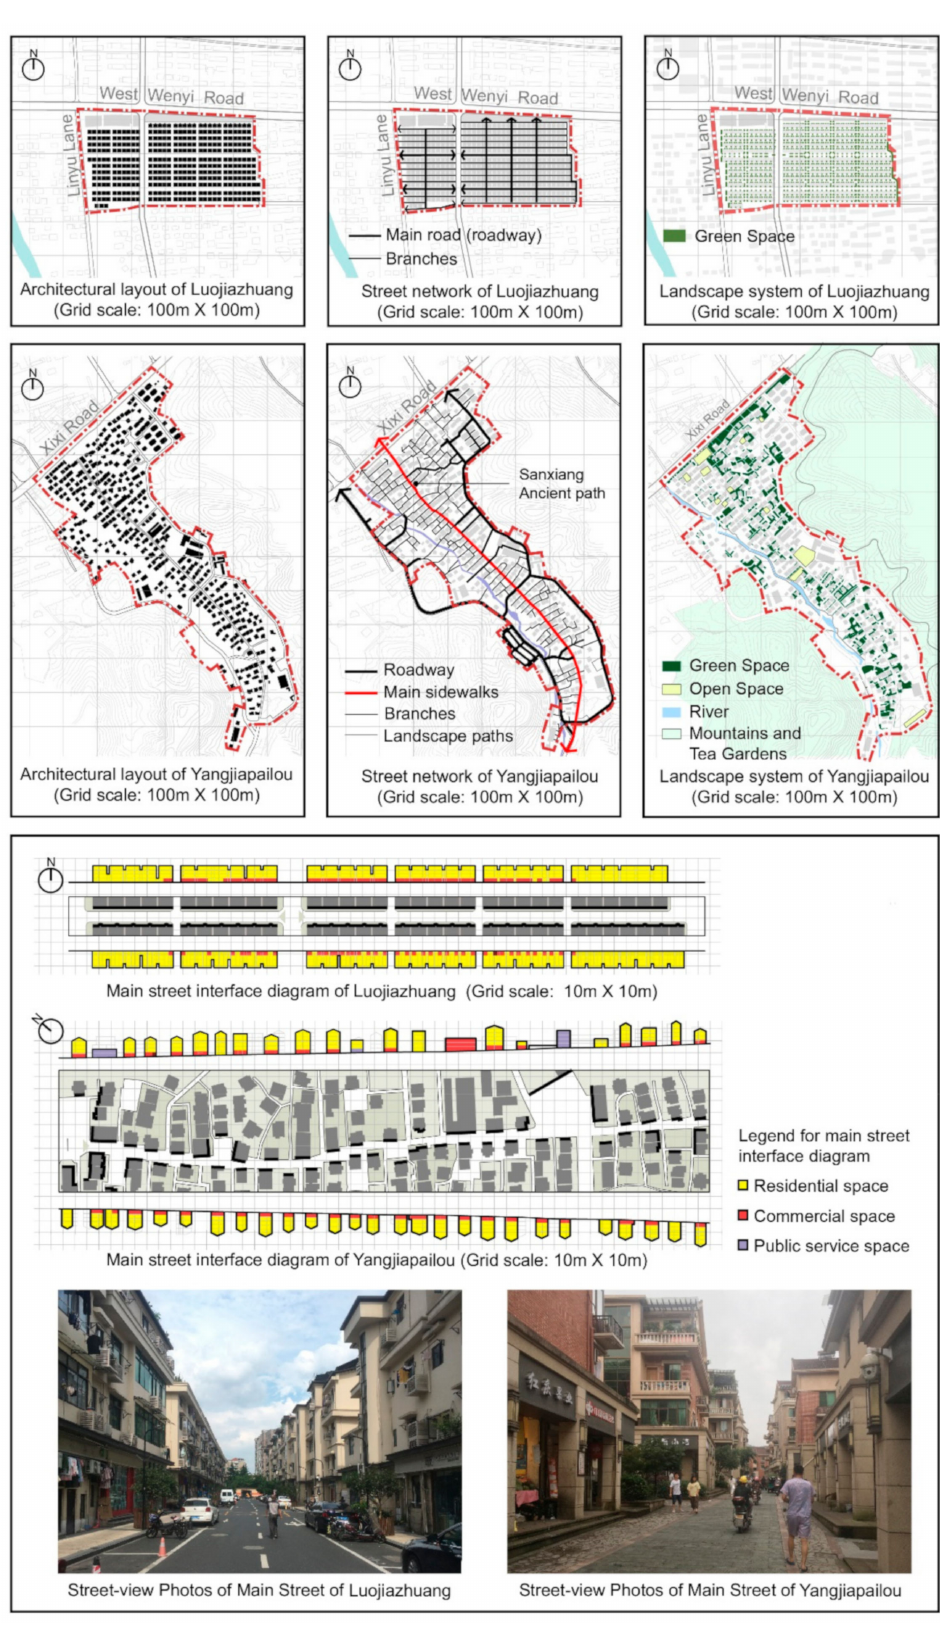
Figure 12. Comparison of spatial patterns in Luojiazhuang and